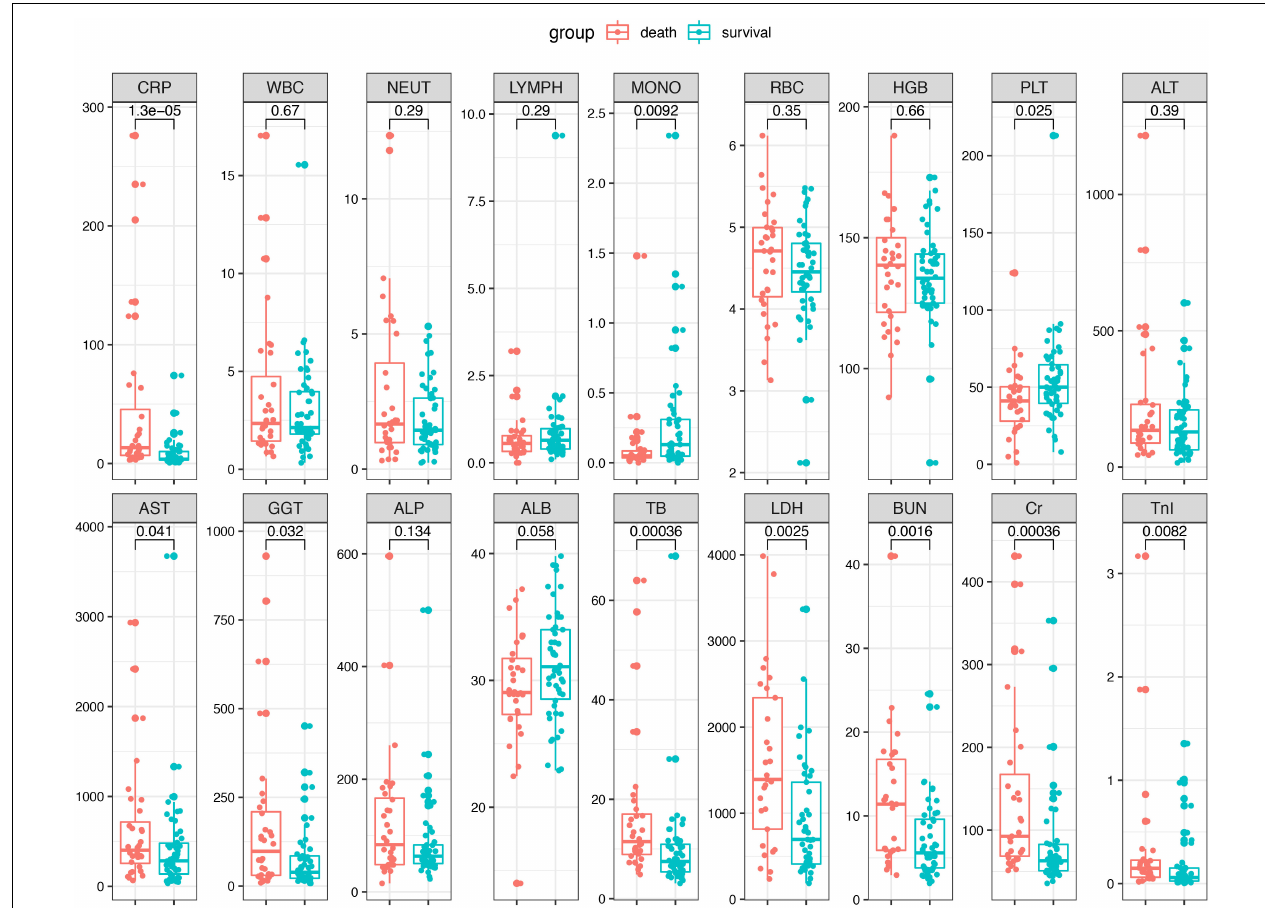
FIGURE 1 | The laboratory parameters were compared between the death patients and survival patients. Statistical significance was calculated by Mann–Whitney U test. Data are presented as median (IQR). WBC, white blood cell; LYMPH, lymphocyte; NEUT, neutrophil; MONO, monocyte; ALT, alanine aminotransferase; AST, aspartate aminotransferase; GGT, gamma-glutamyl transpeptidase; ALP, alkaline phosphatase; ALB, albumin; LDH, lactate dehydrogenase; TB, total bilirubin; BUN, blood urea nitrogen; Cr, creatinine; TnI, cardiac troponin